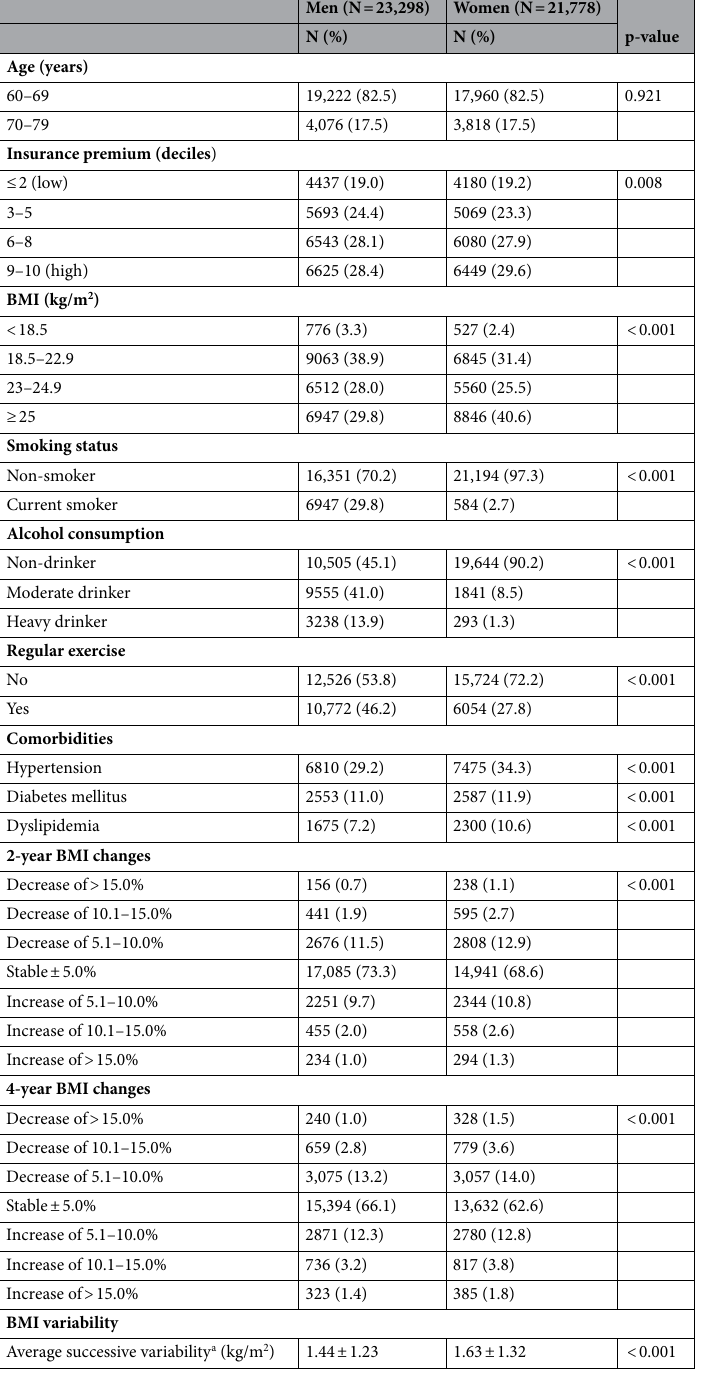
Table 1. Baseline characteristics, BMI changes, and BMI variability of study participants (n = 45,076). BMI body mass index. a Values are presented as mean ± standard